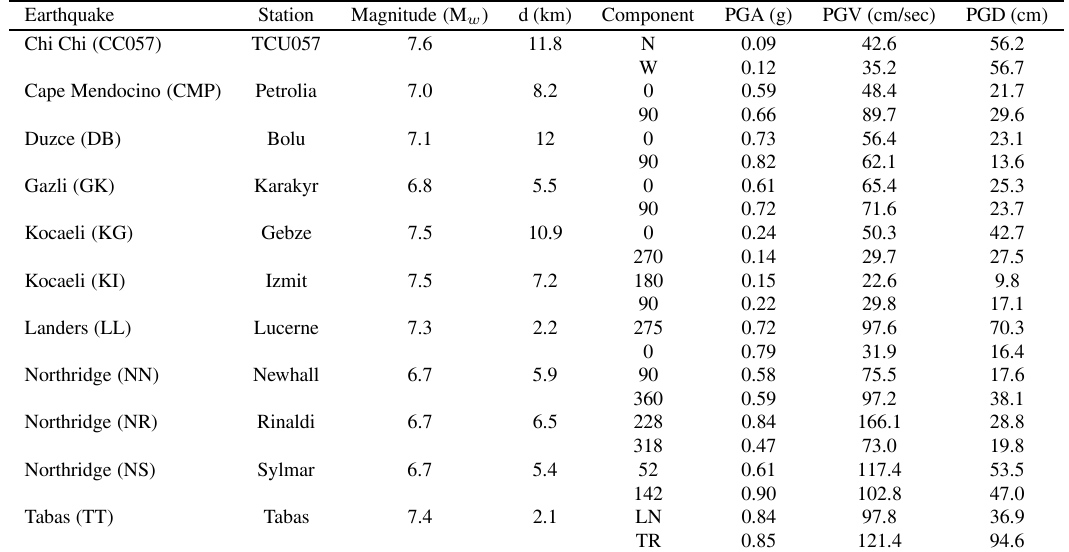
Table 1 Characteristics of near- fi eld ground motions in